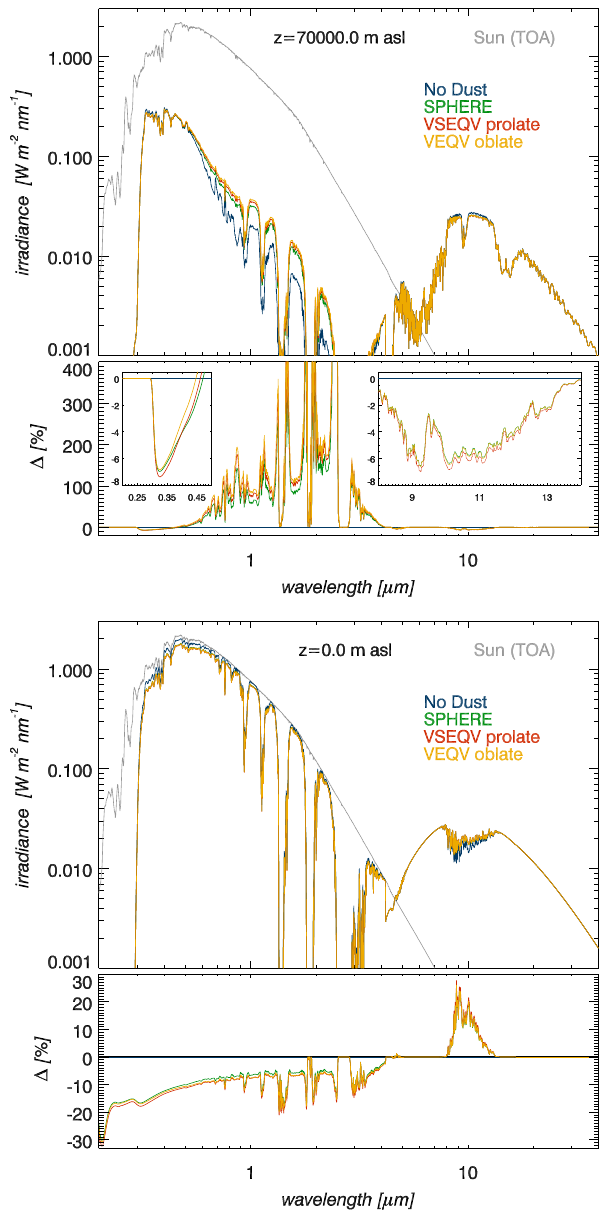
Fig. 13. The same as in Fig. 12, however, for the situation of the observed mineral dust plume, which is now lifted over a mean ocean surface (Fig. 3, bottom) and whose lower boundary is located at z = 1 . 15kma.s.l. whereby the BOA is represented by sea level ( z =